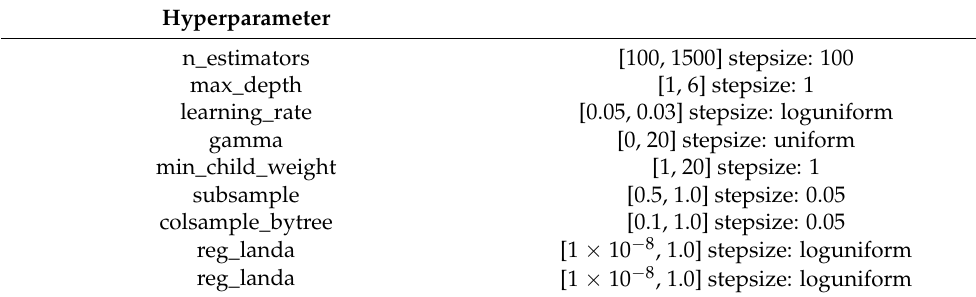
Table 5. Parameter space used for hyperparameter optimization with the Tree-structured Parzen Estimator